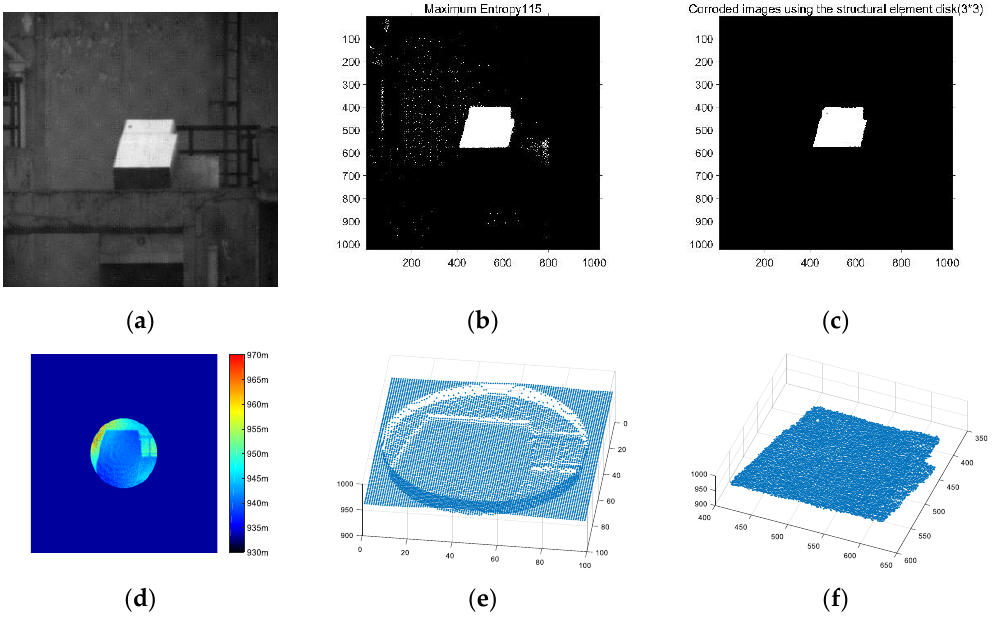
Figure 4. Polarization-modulated 3D imaging Lidar data: ( a ) intensity image; ( b ) maximum entropy segmentation effect; ( c ) binary diagram effect after erosion; ( d ) depth image; ( e ) point clouds in the field of view before segmentation; ( f ) segmentation of target point cloud.